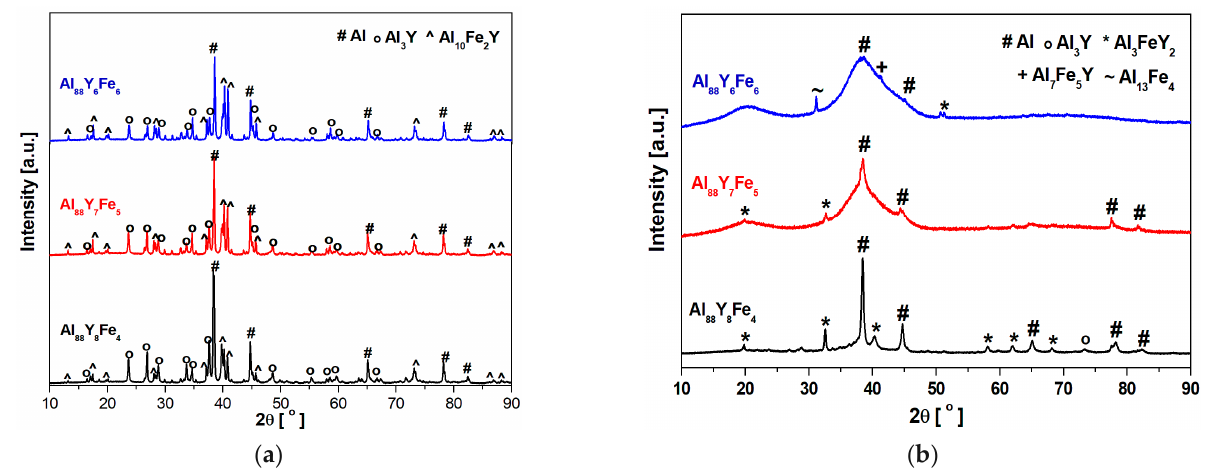
Figure 2. X-ray diffraction (XRD) patterns of Al 88 Y 6 Fe 6 , Al 88 Y 7 Fe 5 , and Al 88 Y 8 Fe 4 alloys in the form of ingots ( a ) and in the form of ribbons ( b ) in as-cast states.